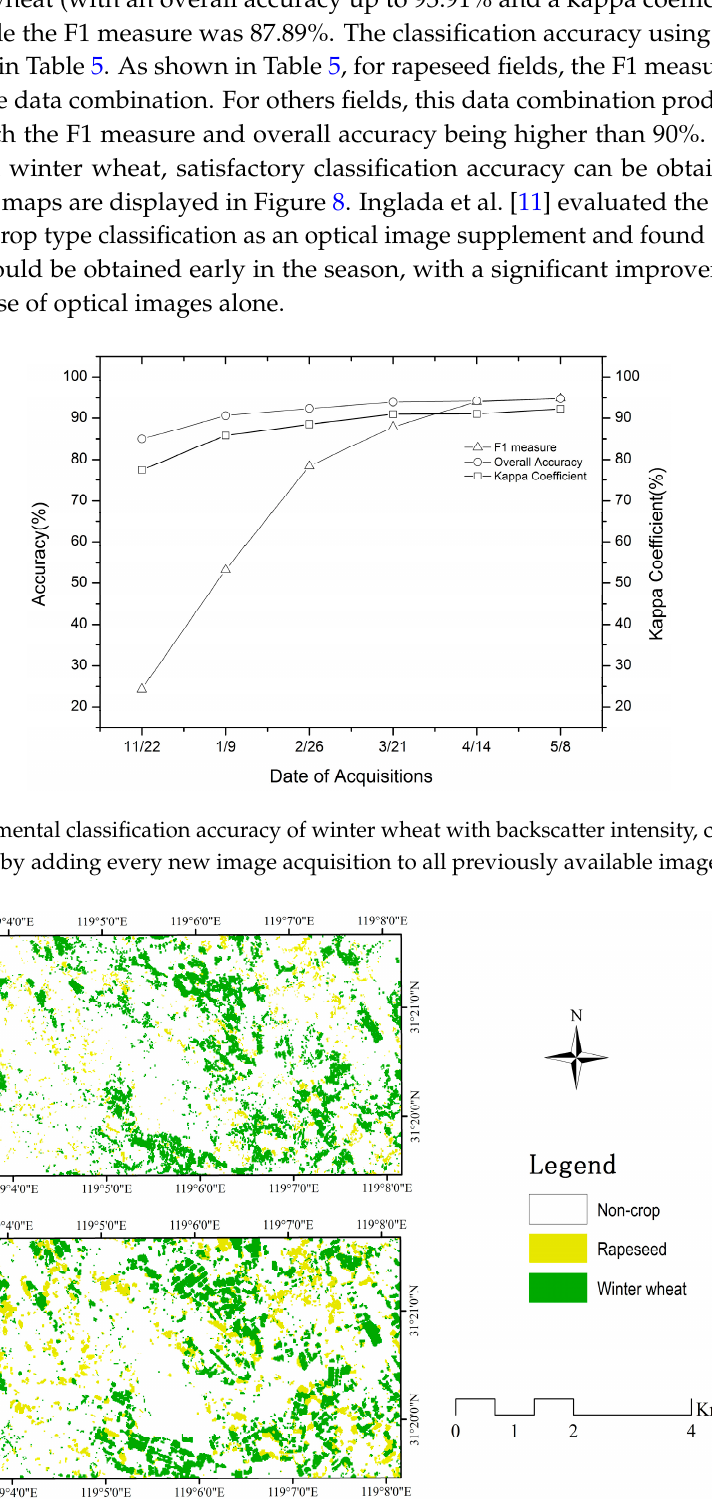
Figure 8. Classification results using the RF classifier. (Top) Using the four SAR datasets (22 November 2015, 9 January 2016, 26 February 2016 and 21 March 2016). (Bottom) Using the combination of S + O. Table 5. Accuracy of winter wheat using the four SAR datasets (22 November 2015, 9 January 2016, 26 February 2016 and 21 March 2016).